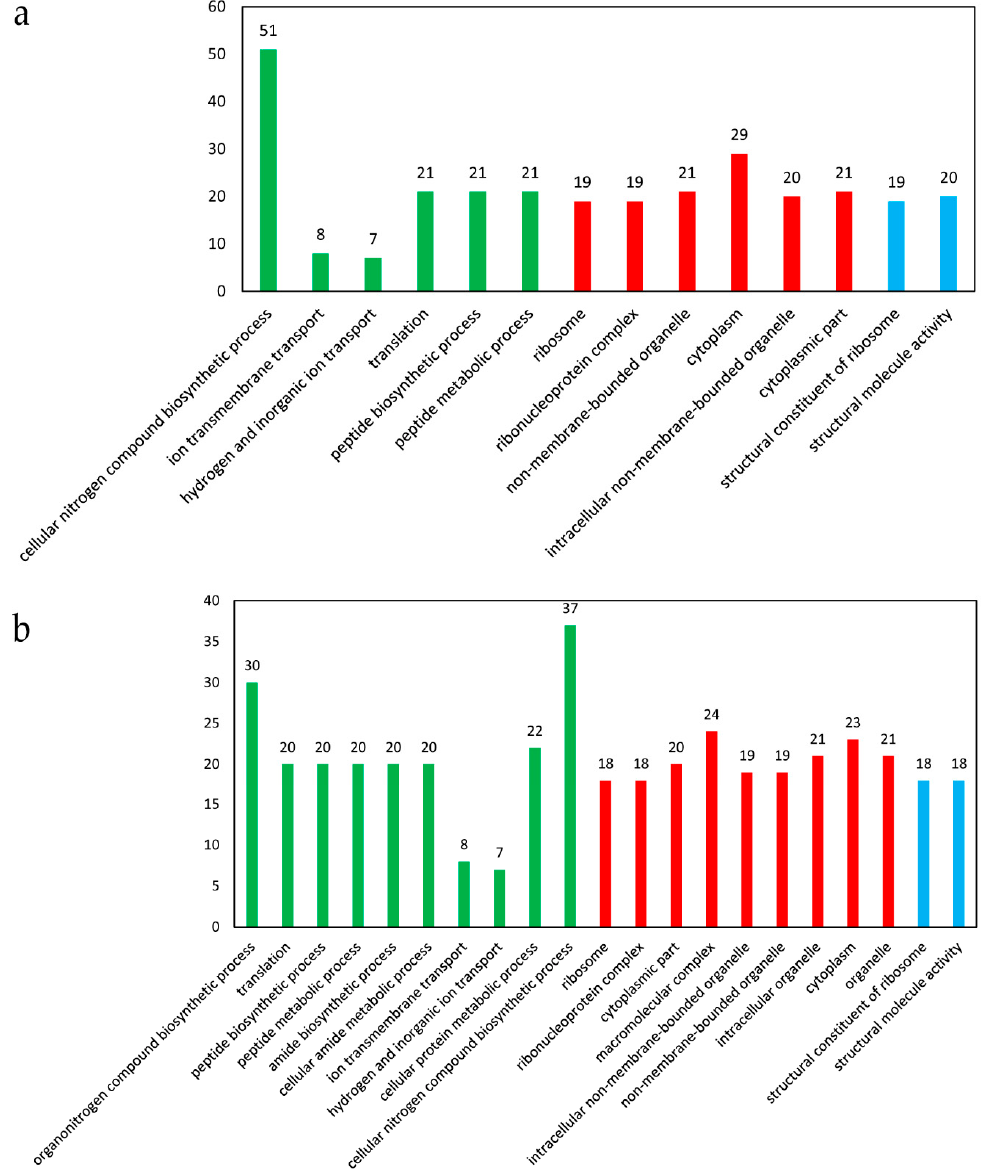
Figure 5. The significantly enriched GO terms of the DEGs in response to cobalt toxicity. ( a ) Analysis of all the DEGs. ( b ) Analysis of the up-regulated genes. The Y -axis indicates the enriched GO terms, and the X -axis indicates the number of the DEGs for each GO term. The GO terms in a green color belonged to biological processes, those in red belonged to cellular components, and those in blue belonged to molecular function. The GO enrichment analysis was performed using the GOseq method with Wallenius non-central hyper-geometric distribution. The GO terms with a corrected p -value < 0.05 were considered to be significantly enriched.